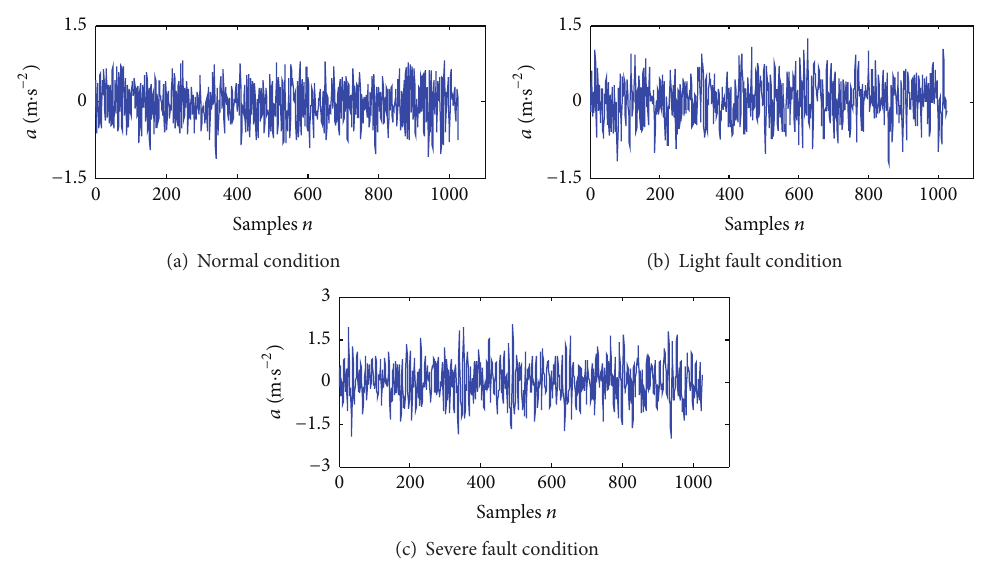
Figure 7: Vibration signal waveforms of the gearbox under different